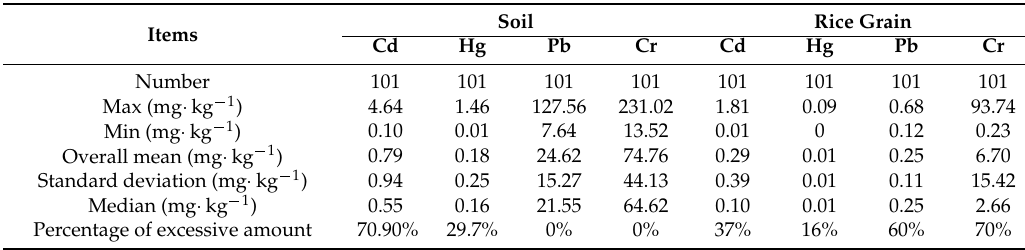
Table 4. The concentrations of four heavy metals (Cd, Hg, Pb, Cr) in soil and rice grain from the Yangtze River of China.